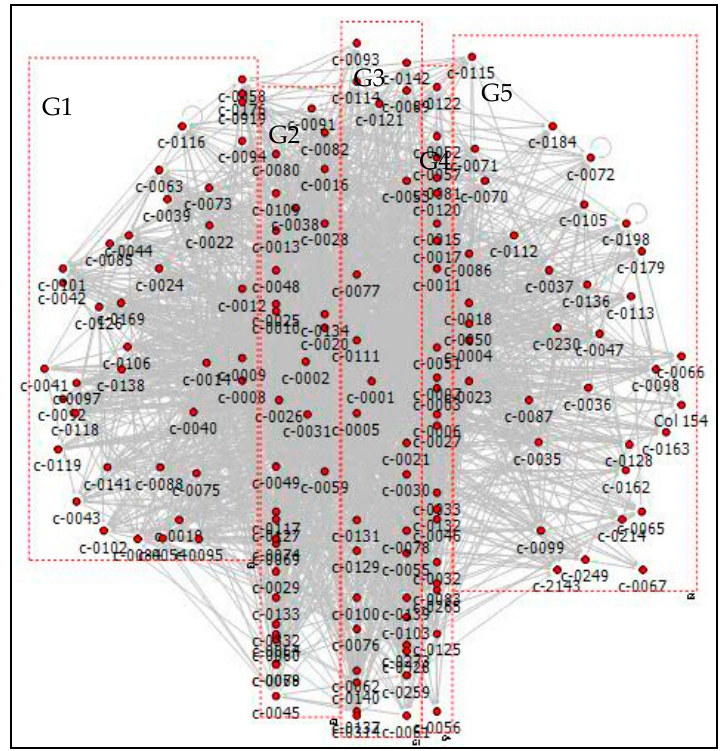
Figure 7. Cluster network structure of cadastral research.